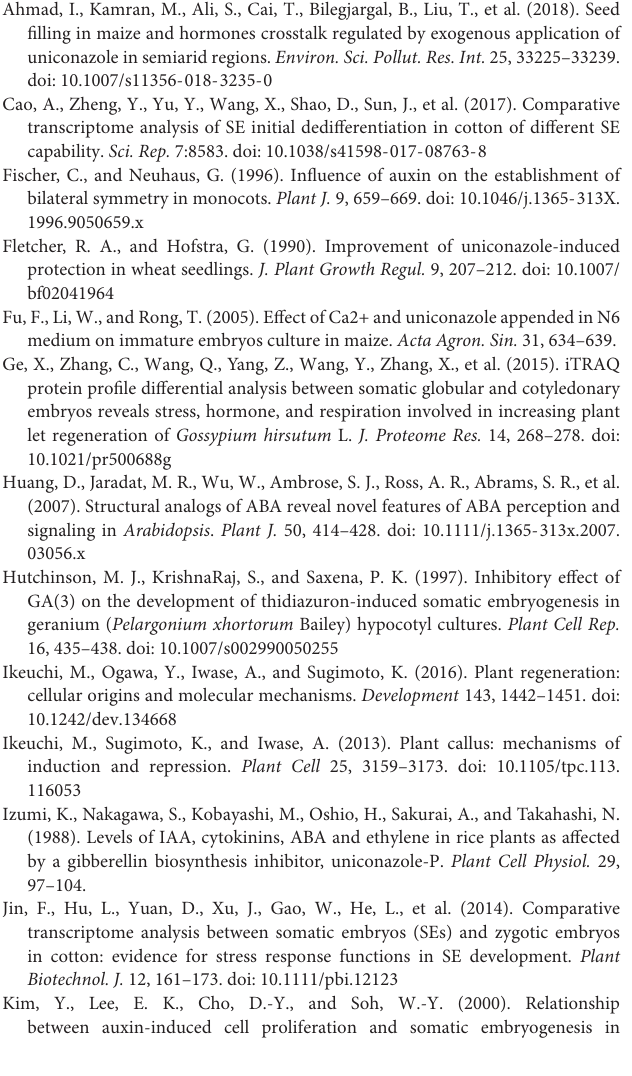
Supplementary Figure 2 | Embryogenic differentiation rate of ZM24 seedling hypocotyl-derived calli cultivated on MS medium supplemented with 0–17 µ M uniconazole. Differentiation of embryogenic callus (EC) was assessed after 60 days of culture. Values represent means ± SD.